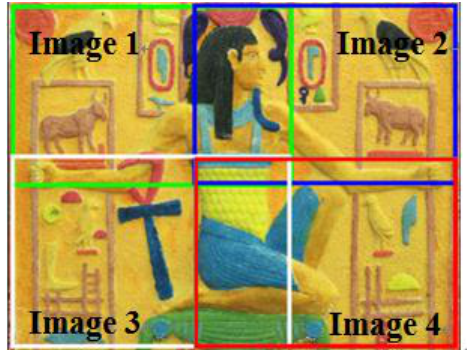
Figure 13.One to one correspondence between local image and